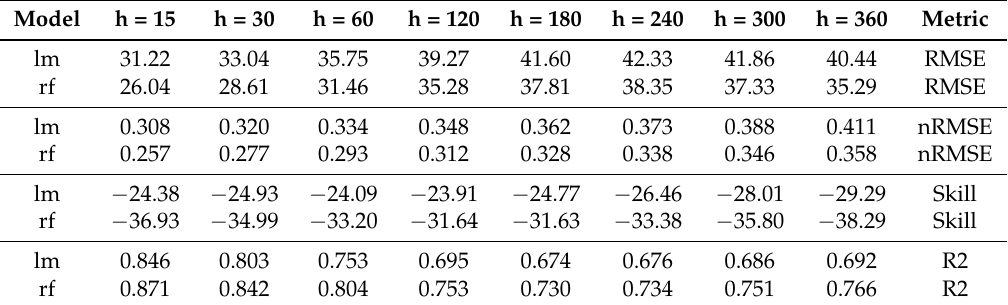
Table 2. Metric comparison of Random Forest against Linear Regression.